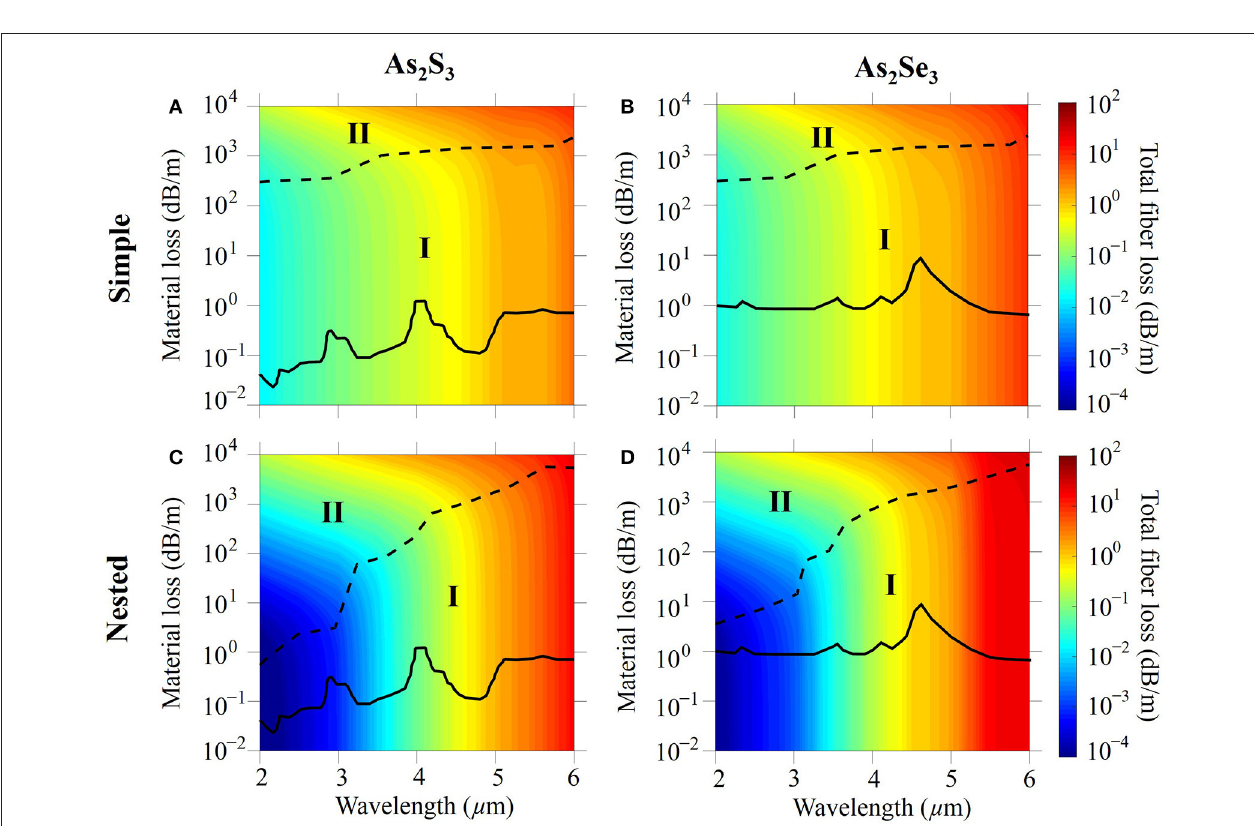
FIGURE 9 | Contour plot of fiber loss in (A) simple and (C) nested negative curvature fibers made with As 2 S 3 chalcogenide glass. Contour plot of fiber loss in (B) simple and (D) nested negative curvature fibers made with As 2 Se 3 chalcogenide glass. The black solid curves show the material loss of chalcogenide glass. The black dashed curves separate regions I and